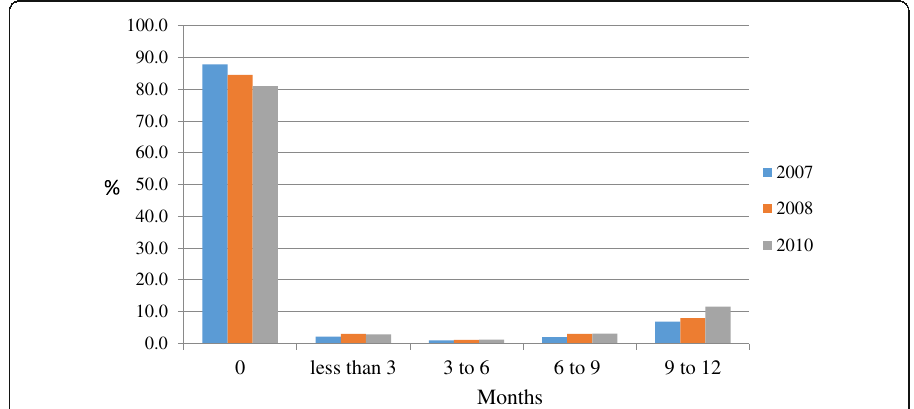
Fig. 1 The length of migration (percent). Source: based on the DFG Rural Household Surveys 2007, 2008, and